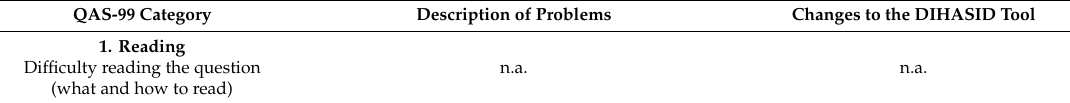
Table 3. Problems identified in cognitive interviews and changes to improve the clarity of the DIHASID